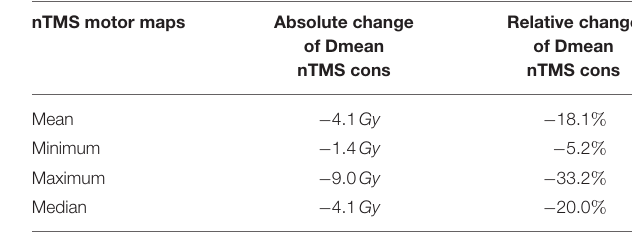
TABLE 3 | Relative and absolute dose applied to motor maps.